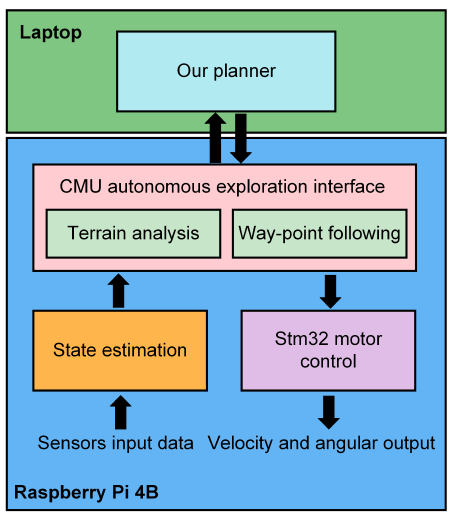
Figure 22. The main structure of autonomous